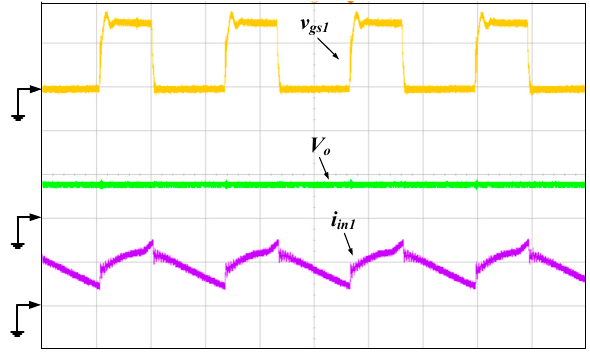
Figure 15. The waveforms of output voltage and current while step change occurs at load.